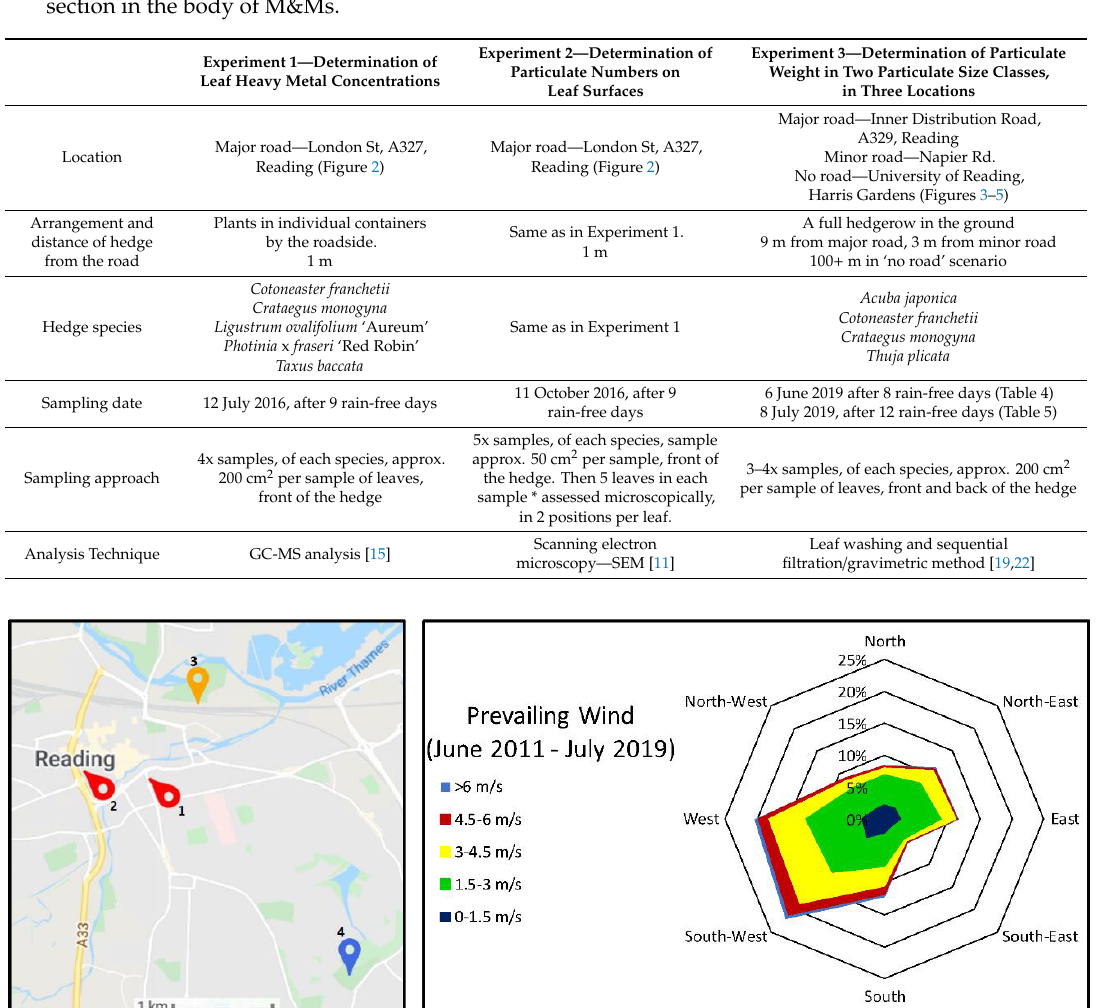
Table 1. Summary of experimental context and methodologies. * Apart from Taxus , see the microscopy section in the body of M&Ms.